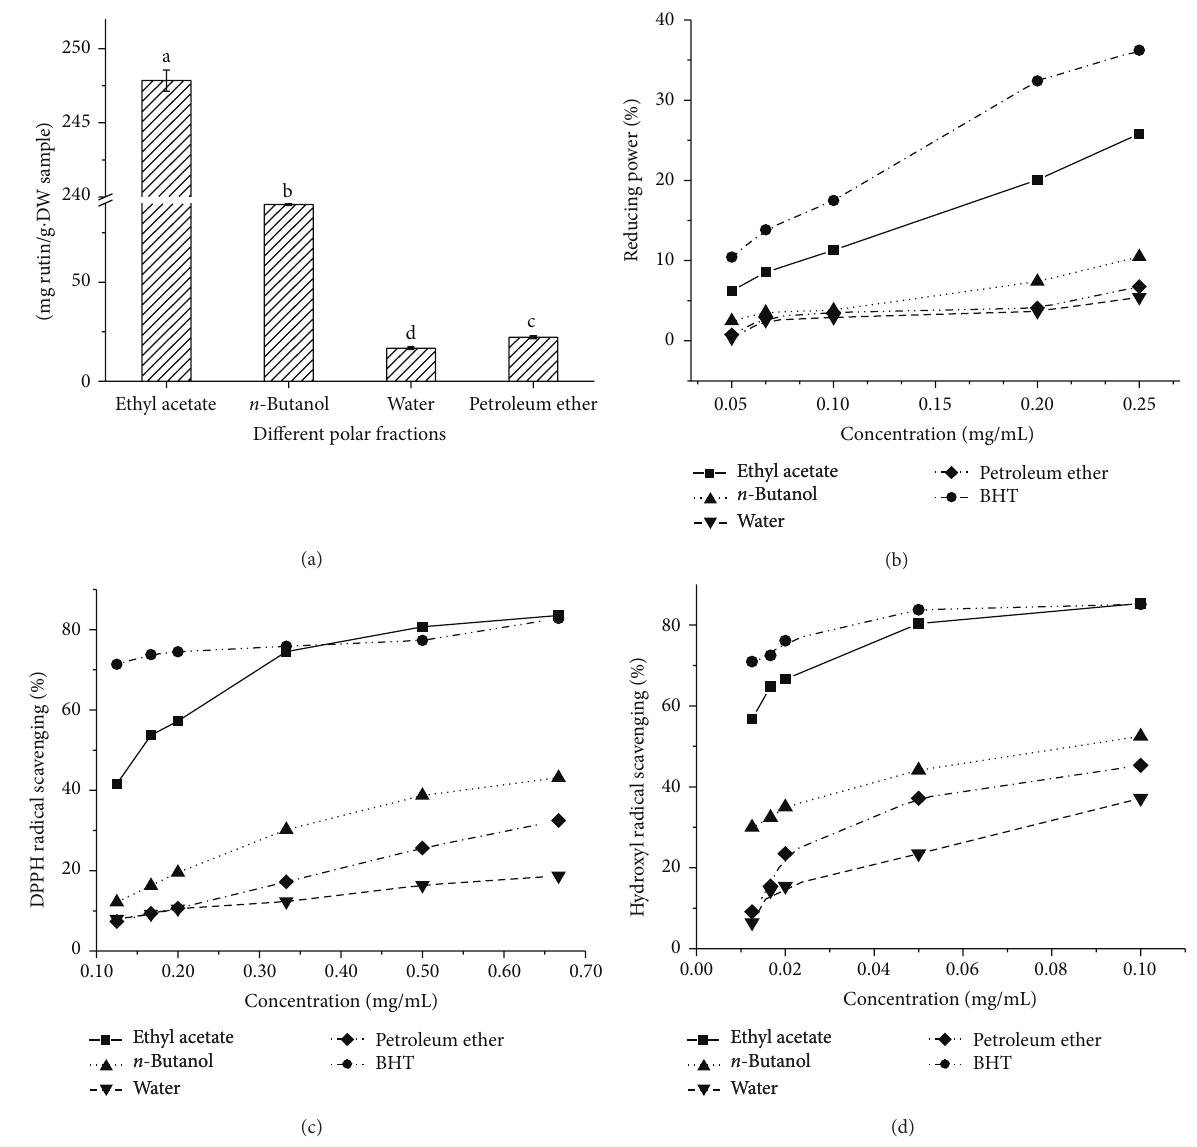
Figure 1: Total flavonoid content and antioxidant activity of various fractions of CA6. (a) Total flavonoid content; (b) reducing power; (c) DPPH radical scavenging activity; (d) hydroxyl radical scavenging